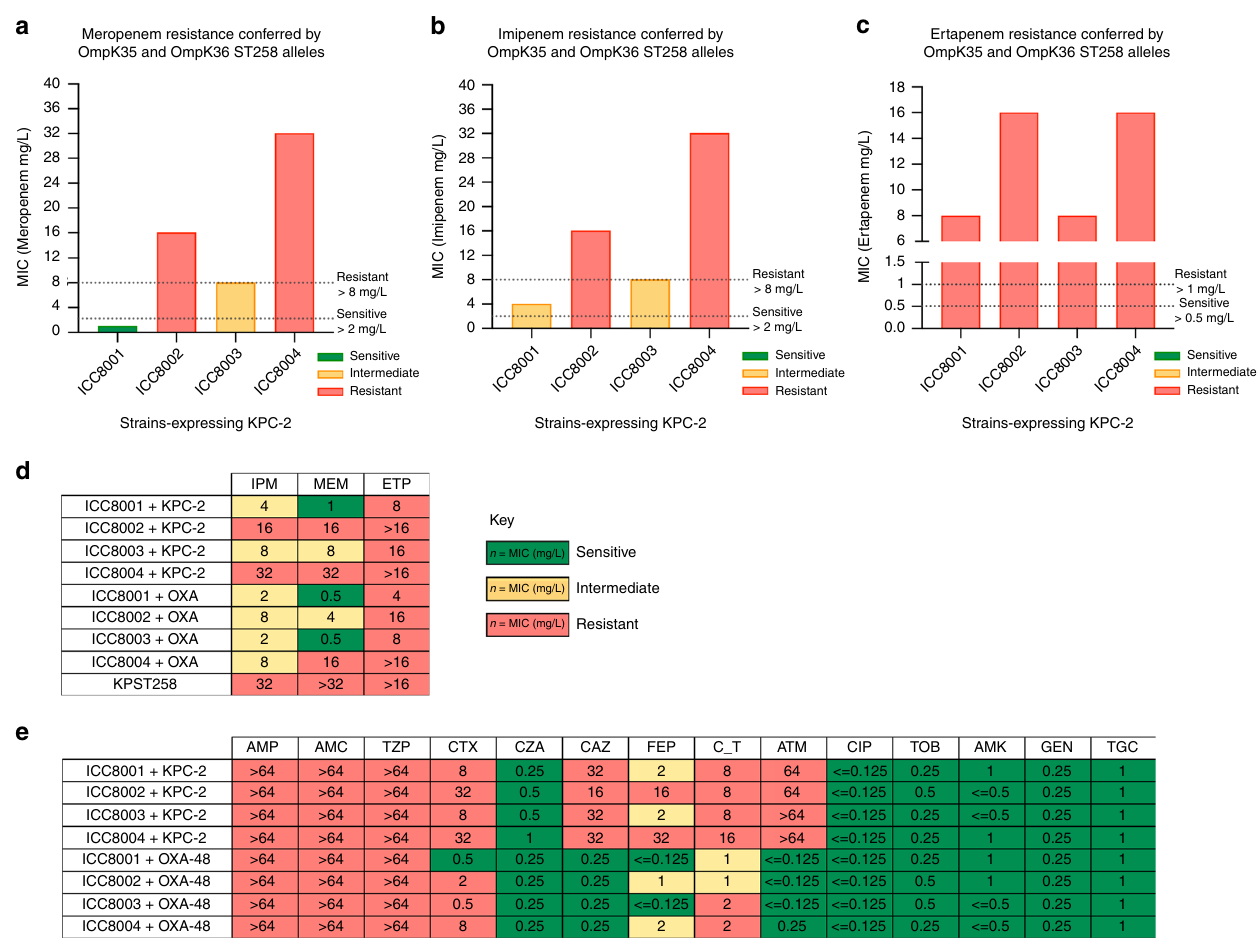
Fig. 2 The impact of OmpK35 ST258 and OmpK36 ST258 substitution on resistance to antibiotics used in Gram-negative infections. a Meropenem, b Imipenem and c Ertapenem broth minimum inhibitory concentrations presented graphically in isogenic strains expressing the KPC-2 carbapenemase. Dotted lines represent sensitive and resistant EUCAST breakpoints. d Broth MIC of the isogenic KP strains expressing the KPC-2 or OXA-48 carbapenemase. Individual values are colour coded (green — sensitive, yellow — intermediate and red — resistant) according to their antibiotic resistance de fi ned by EUCAST breakpoints. Antibiotic key: IPM Imipenem, MEM Meropenem, ETP Ertapenem. e Resistance to other antibiotics in different classes tested. Individual values are colour coded (green — sensitive, yellow — intermediate and red — resistant) according to their antibiotic resistance de fi ned by EUCAST breakpoints. Antibiotic key: AMP Ampicillin, AMC Amoxicillin/Clavulanate (2:1), TZP Pipericillin/Tazobactam, CTX Cefotaxime, CZA Ceftazidime/Avibactam, CAZ Ceftazidime, FEP Ce fi pime, C_T Ceftolozone/Tazobactam, ATM Aztreonam, CIP Cipro fl oxicin, TOB Tobramycin, AMK Amikacin, GEN Gentamicin, TGC